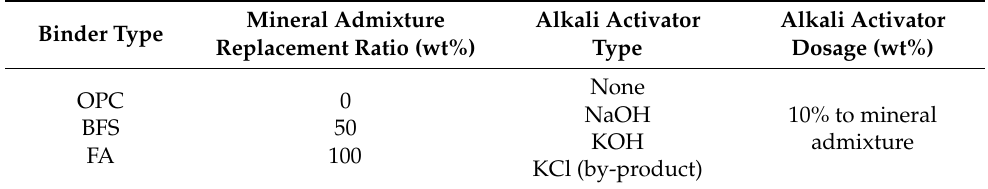
Table 1. Binders, replacement ratios, alkali activator types, and alkali activator dosages used in this experimental design.